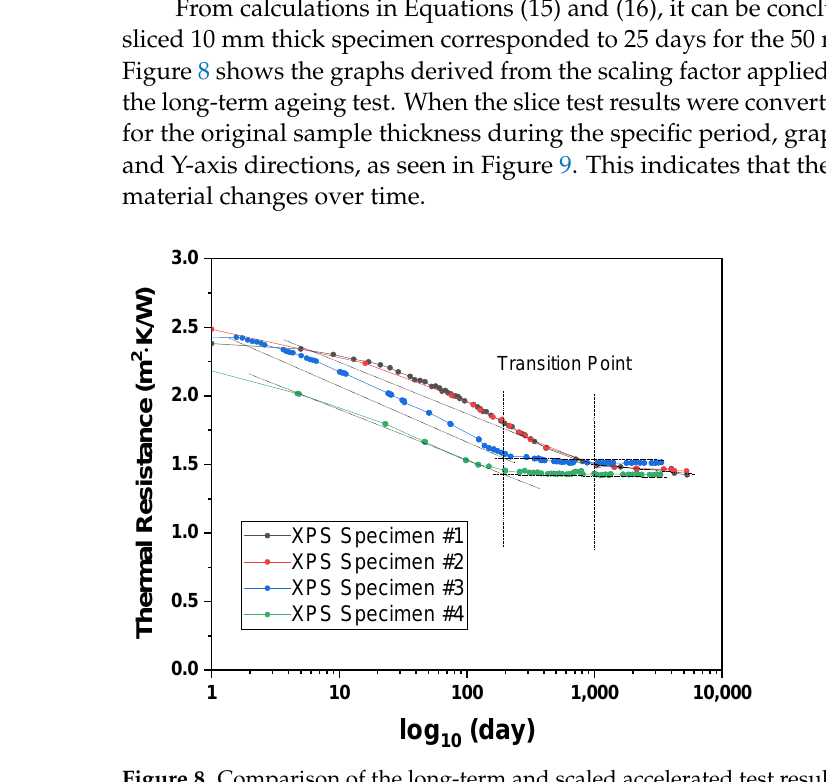
Figure 8. Comparison of the long-term and scaled accelerated test results.